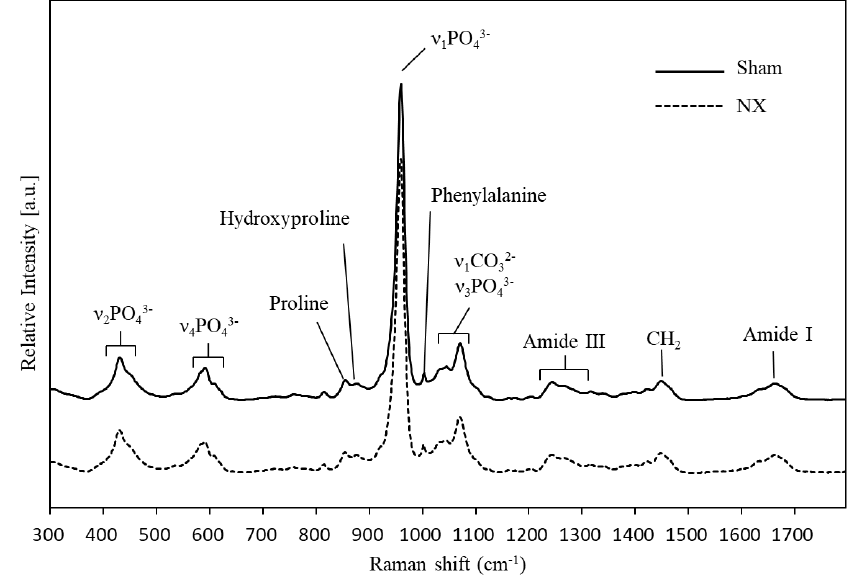
Figure 1. The average Raman spectra obtained from neurectomized (NX group) mice and Sham operation mice (Sham group). Previous studies can be used to assign apparent peaks in Raman spectra originating from the bone mineral and matrix components (Table 1). Raman peaks originating from the mineral components are as follows: ν 2 PO 43 − , 430–450 cm − 1 ; ν 4 PO 43 − , 584–610 cm − 1 ; ν 1 PO 43 − , 960 cm − 1 ; and ν 1 CO 32 − ν 3 PO 43 − , 1035–1076 cm − 1 . Those originating from the matrix components are as follows: Proline, 855 cm − 1 and 922 cm − 1 ; hydroxyproline, 876 cm − 1 ; phenylalanine, 1002 cm − 1 ; amide III, 1243–1320 cm − 1 ; CH 2 , 1448 cm − 1 ; and amide I, 1664 cm − 1 . Table 1. Assignment of Raman peaks in bone tissue, as in References [20,33]. Raman Shift, cm − 1